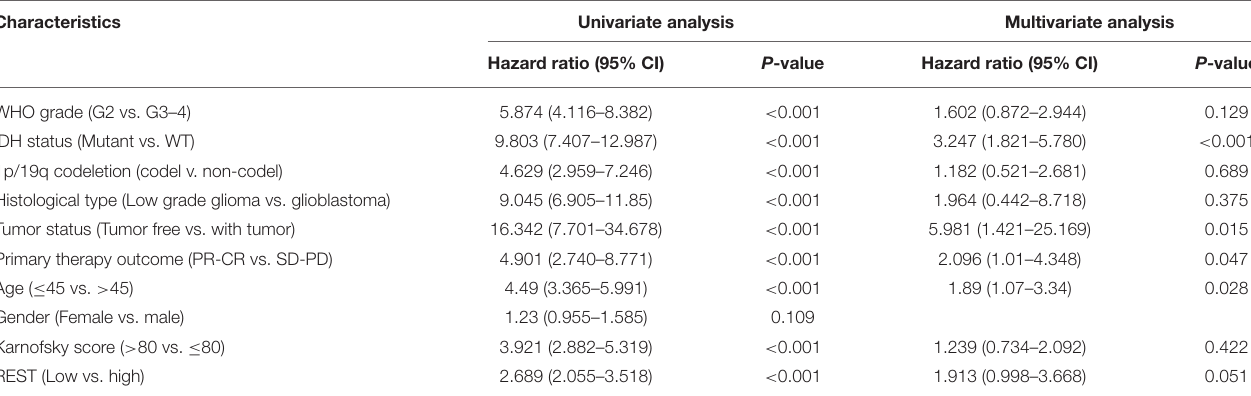
TABLE 3 | The overall survival (OS) univariate and multivariate cox proportional risk analysis.